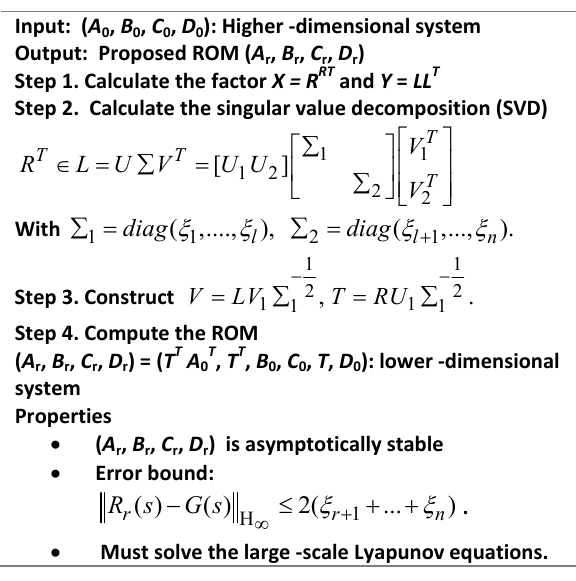
Table 3: MOR Algorithm Using Balanced Truncation